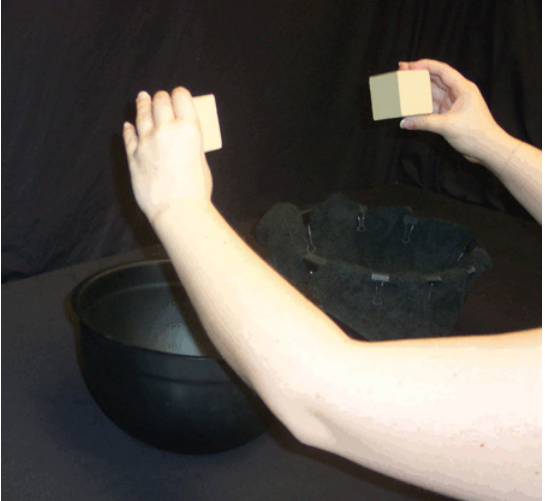
Fig 3. Bowls. Participant holding blocks approximately 20 cm above the